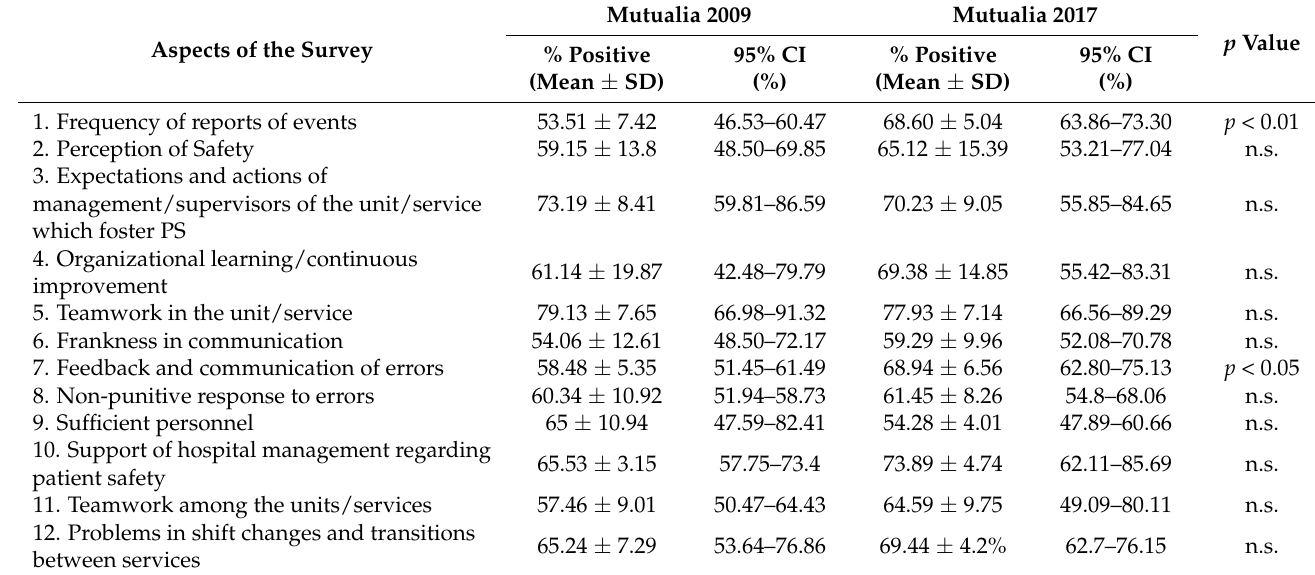
Table 4. Scores obtained in each aspect at Mutualia (2009 and